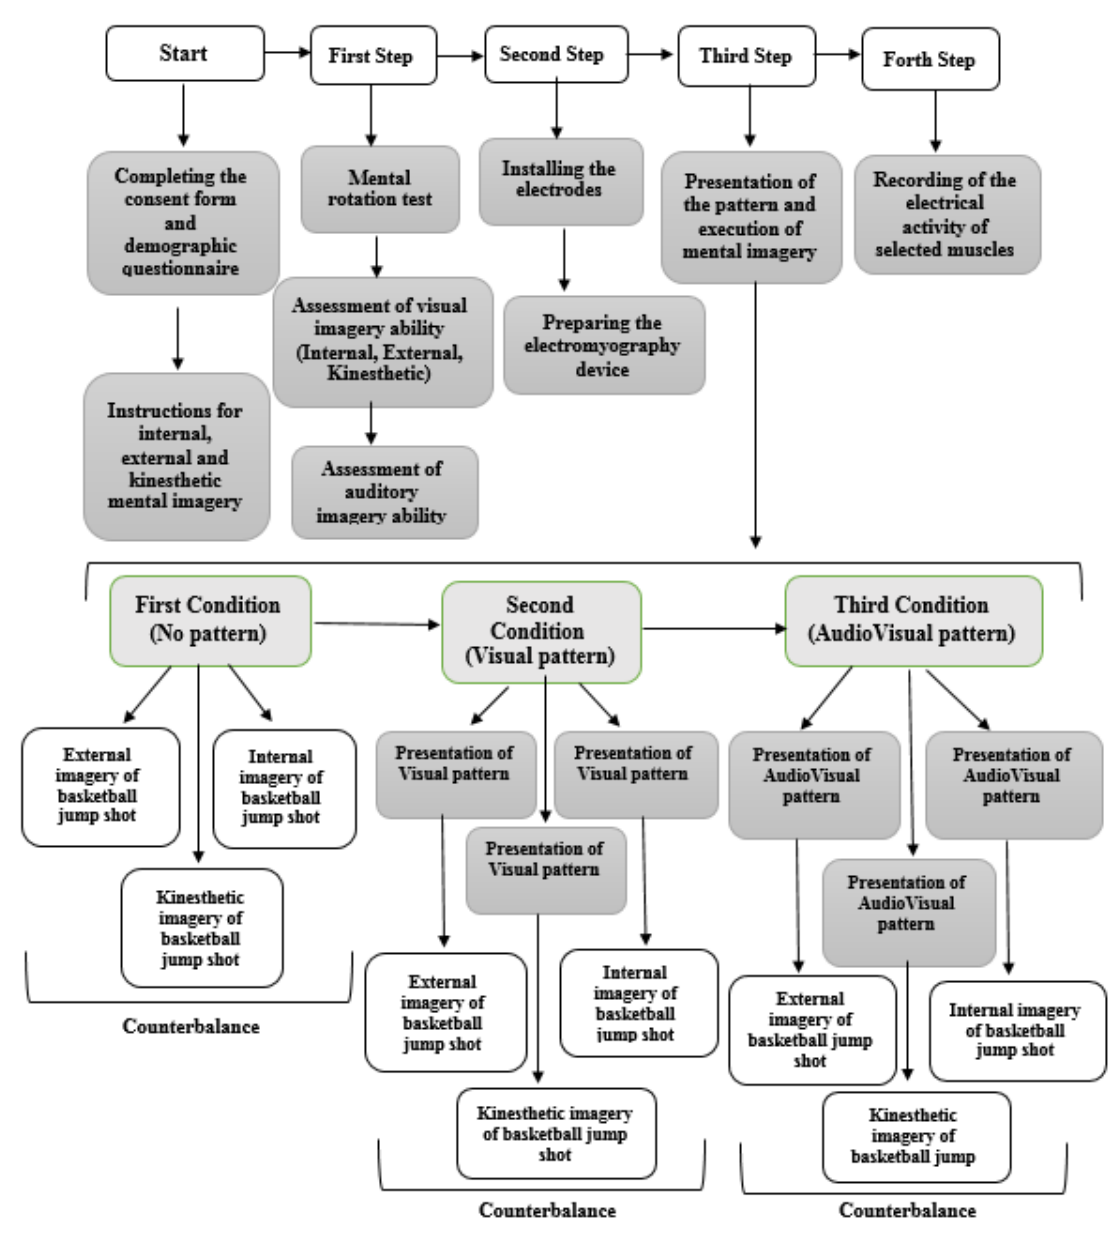
Figure 2. Overview of research methodology .